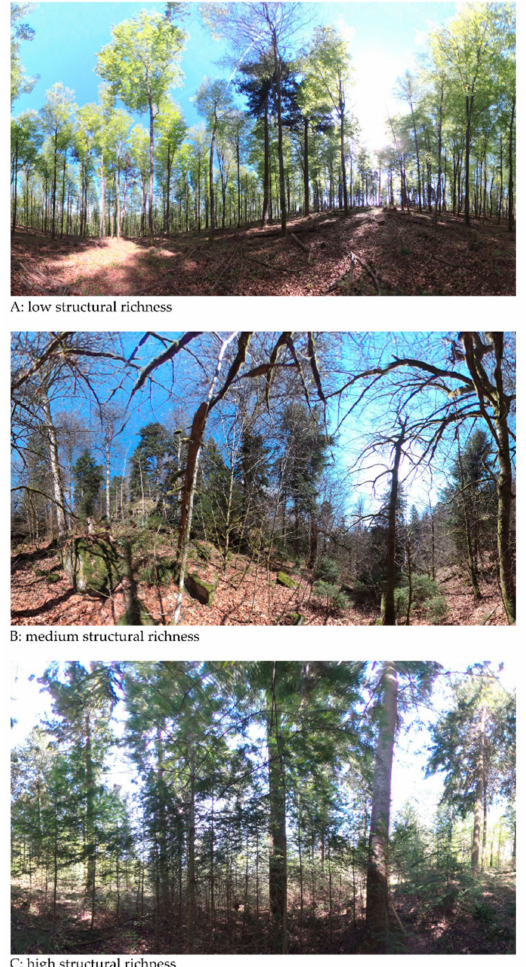
Figure 5. 360 ◦ -images of the calibration phase of the questionnaire, which have been projected to the spherical image viewer. Here depicted in planar Mercator projection for better visibility. The high, medium and low structural richness has been derived according to the SSCI rank